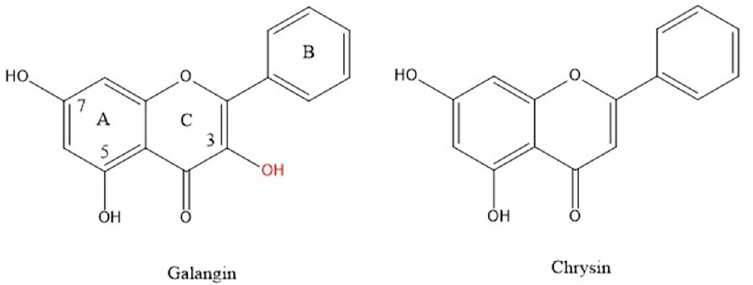
Fig 4. Galangin, 3,5,7-trihydroxyflavone, and chrysin, 5,7-dihydroxyflavone, are important components of propolis.